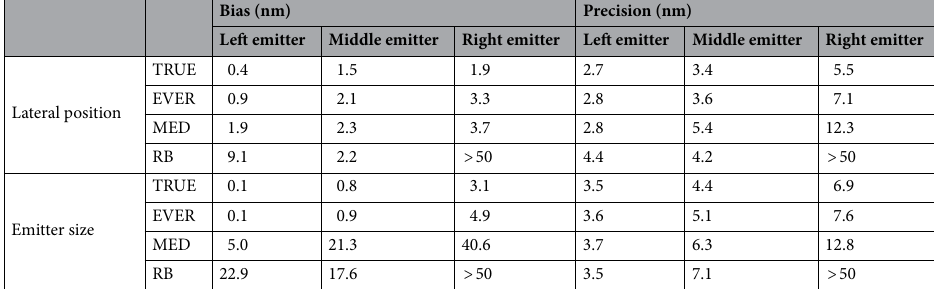
Table 1. Localization bias and precision* of the emitter positions (x-dimension) and size for recovered emitters from the ground truth (TRUE), EVER, MED and RB. The localization bias is defined as the mean value of the localization error, and the localization precision is defined as the standard deviation of the localization